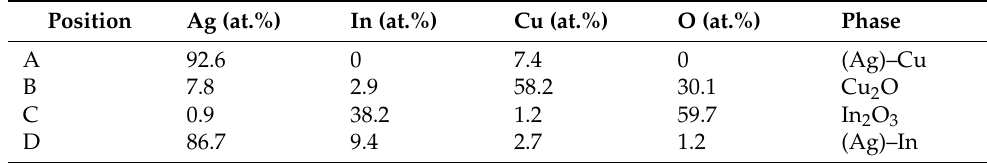
Figure 10. ( a ) Cross-section microstructure of the middle of the Ag–In alloy joint bonded at 10 MPa after HTS at 300 ◦ C for 100 h. ( b – e ) Elemental distributions of ( a ). Table 2. Composition determined using EPMA at the positions indicated in Figure